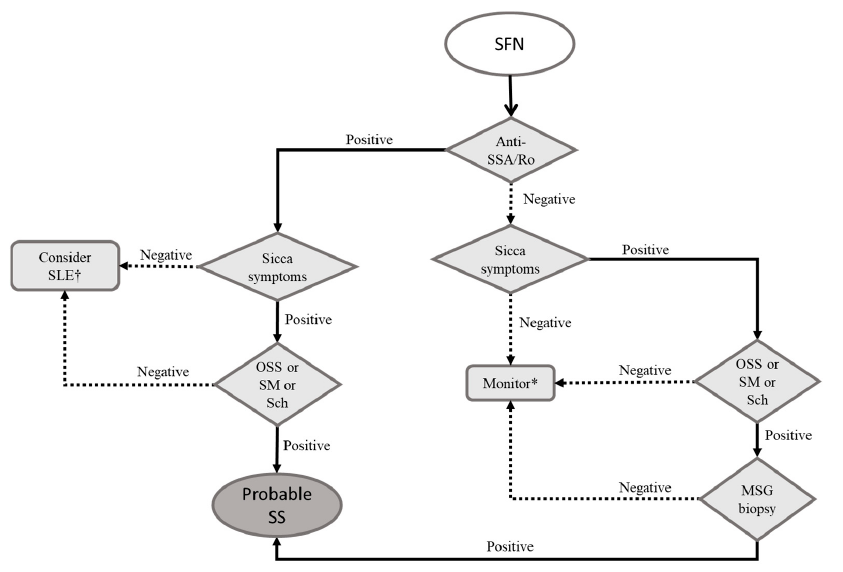
Figure 1. Proposed diagnostic flowchart for patients with small fiber neuropathy. Notes: Anti- SSA/Ro is the main autoantibody related to Sjögren’s syndrome and part of the contemporary diagnostic criteria. Sicca symptoms refer to the complaints related to dryness of the mouth, eyes, skin, and genital and respiratory tracts. Legend: MSG: minor salivary gland; OSS: ocular staining score (ophthalmic exam with specific dyes aiming to document and quantify eye surface’s lesions); Sch: Schirmer’s test (quantification of lacrimal flow volume by time unit); SFN: small fiber neuropathy; SLE: systemic lupus erythematosus; SM: unstimulated sialometry (simple quantification of salivary flow volume by time unit); SS: Sjögren syndrome. * Consider treating neuropathic pain and